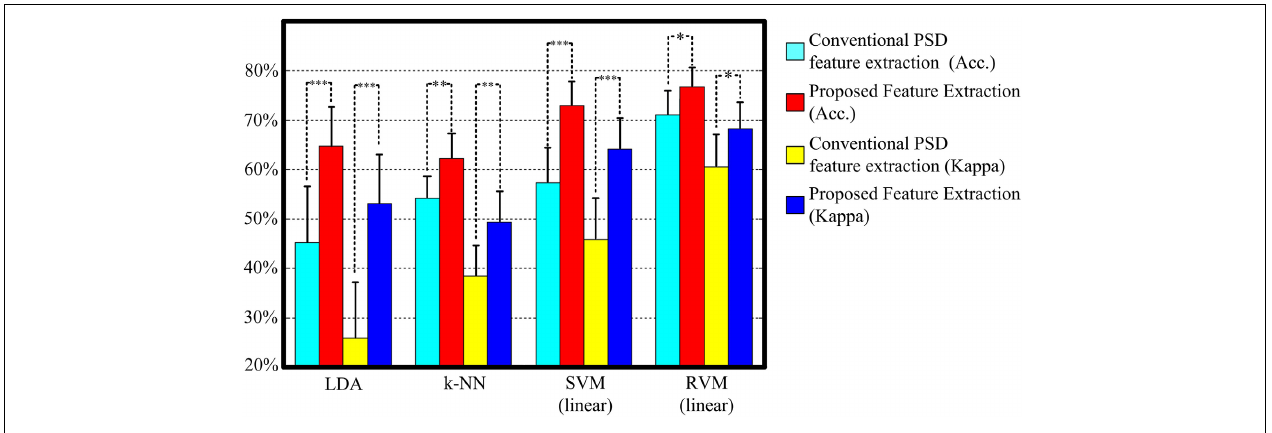
FIGURE 5 | The classification performance comparison between overall accuracy and Cohen’s kappa coefficient, respectively. Error bars conventional frequency PSD feature extraction and the proposed feature indicate standard deviations. For better visualization, the kappa values have extraction with LDA, k-NN, SVM, and RVM. Acc. and kappa represents Table 3 | Comparison of feature extraction approaches in terms of classification performance. Conventional PSD feature extraction